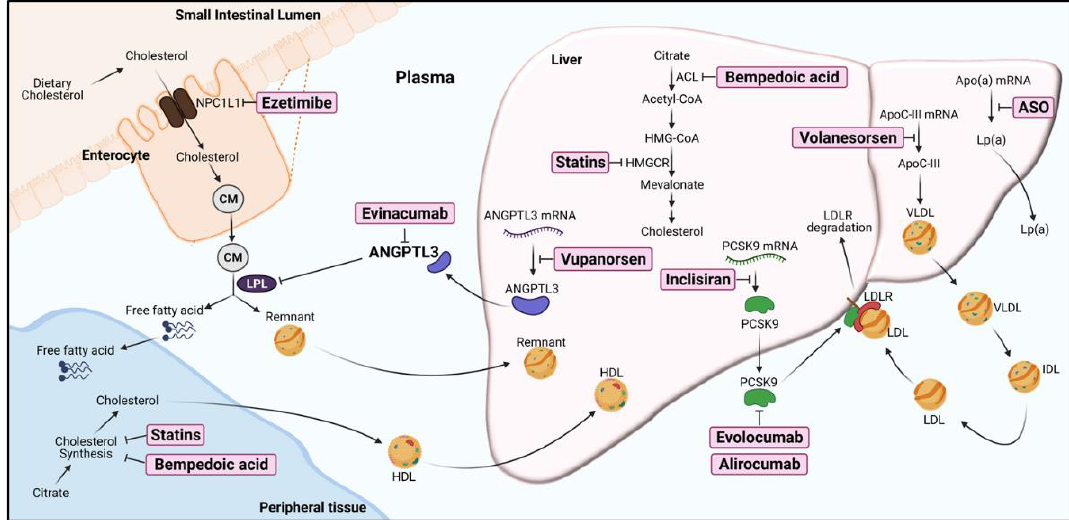
Figure 1. The pharmacological targets of current or potential lipid-lowering agents for dyslipidemia therapy. ACL, ATP-citrate lyase; ANGPTL3, angiopoietin-like protein 3, Apo(a), Apolipoprotein(a); ApoC-III, Apolipoprotein C-III; ASO, antisense oligonucleotides; CM, chylomicrons; HDL, high-density lipoproteins; HMG-CoA, 3-hydroxy-3-methyl-glutaryl-coenzyme A; HMGCR, 3-hydroxy-3-methyl-glutaryl-coenzyme A reductase; IDL, intermediate-density lipoprotein; LDL, low-density lipoproteins; LDLR, low-density lipoprotein receptor; LPL, lipoprotein lipase; Lp(a), lipoprotein (a); NPC1L1, Niemann-Pick C1-like 1 protein; PCSK9, proprotein convertase subtilisin/kexin type 9; VLDL, very-low-density lipoproteins. The approaches for inhibition of targets in lipid/lipoprotein metabolism are highlighted in the boxes (created with BioRender.com, accessed on 2 July 2021).